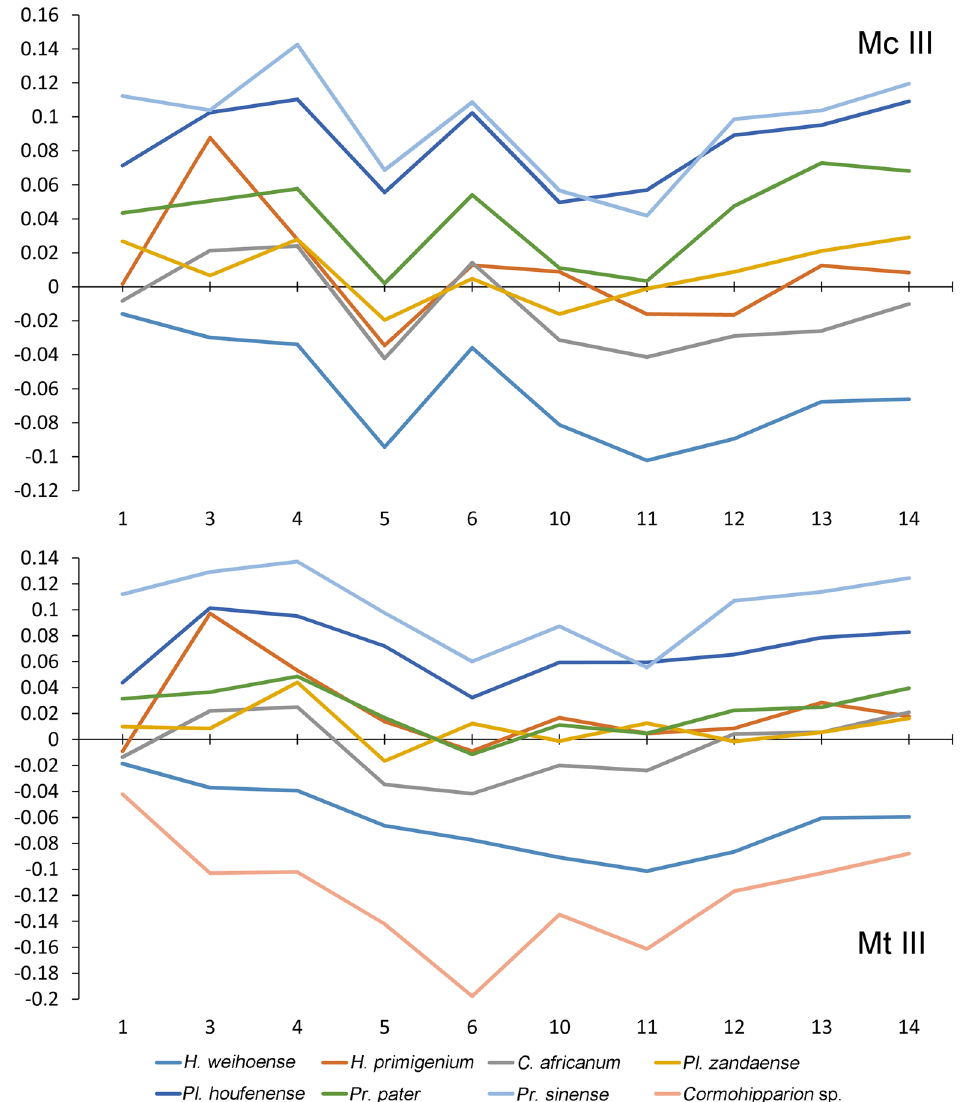
Figure 2. Ratio diagrams of metapodials of H . weihoense and other equids. Measurement numbers: 1, maximal length; 3, minimal breadth; 4, depth of the shaft; 5, proximal articular breadth; 6, proximal articular depth; 10, distal maximal supra–articular breadth; 11, distal maximal articular breadth; 12, distal maximal depth of the keel; 13, distal minimal depth of the lateral condyle; 14, distal maximal depth of the medial condyle. The y axis is the logarithm (base 10) of ratios between the measurements of each species and the reference species (Asiatic wild ass Equus hemionus onager , zero line) (generated with Microsoft Excel version 2010 by B.